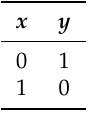
Table 1. Truth table for NOT.